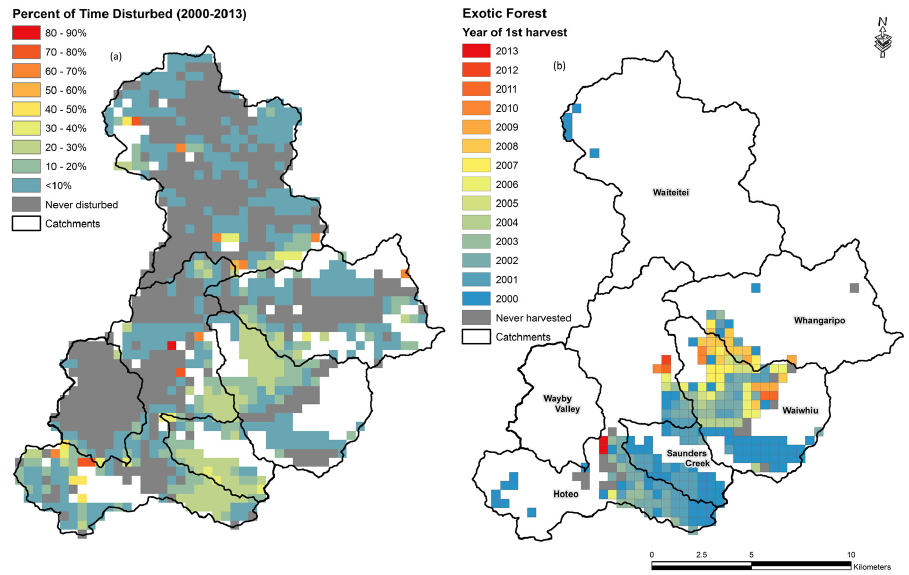
Figure 2. ( a ) Percent of time of every pixel being disturbed for the 2000–2013 period. White pixels were native forests, which were not assessed for disturbance. ( b ) The year of first harvest for each one of the exotic forestry pixels. Forests that were not harvested during the study period are shown as grey.